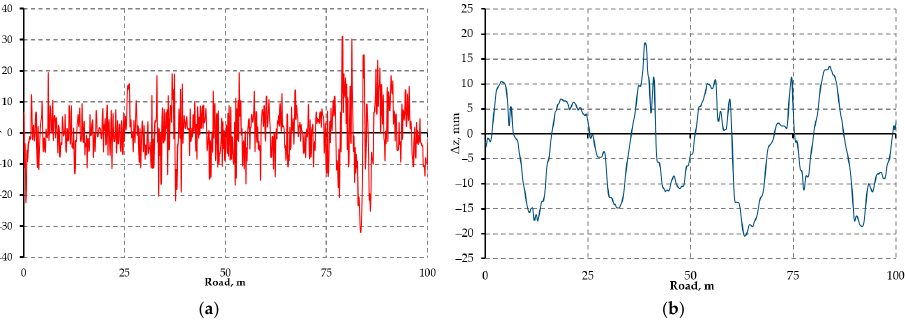
Figure 30. Difference between the sprung and unsprung mass displacements Δ z simulating driving at the speed of 70 km/h: ( a )-experiment and ( b )-model.